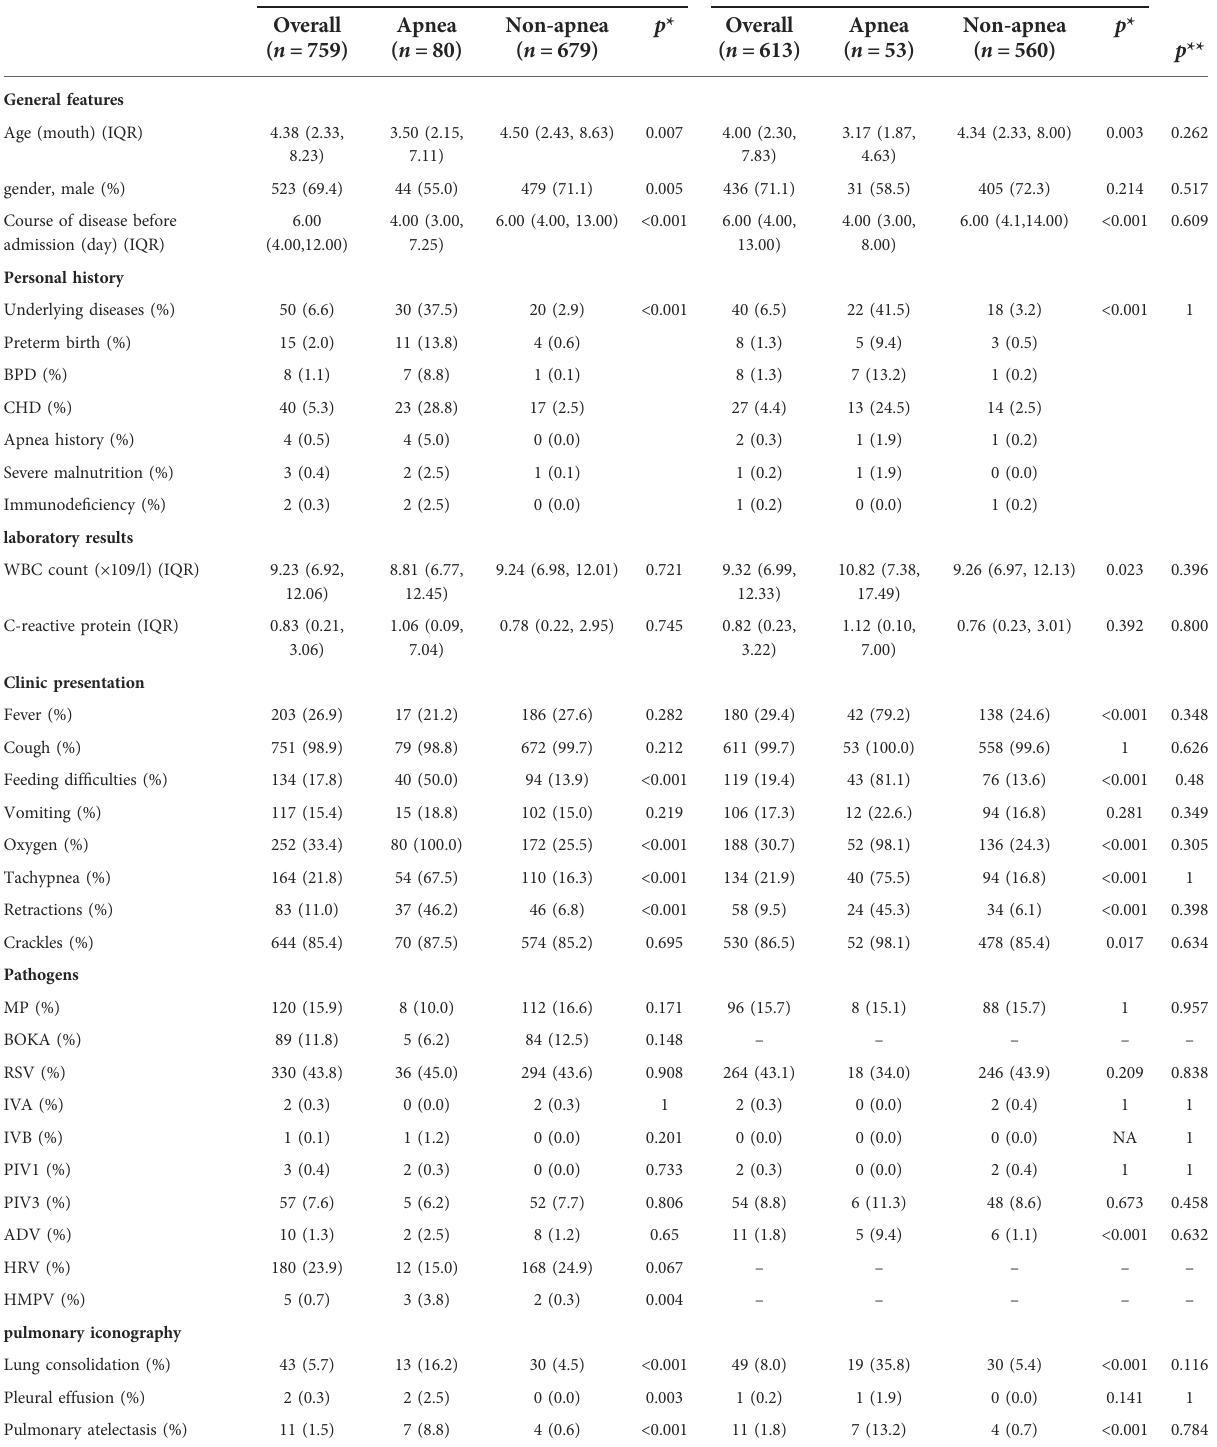
TABLE 1 Demographic, clinical characteristics, and pathogens in patients with apnea and